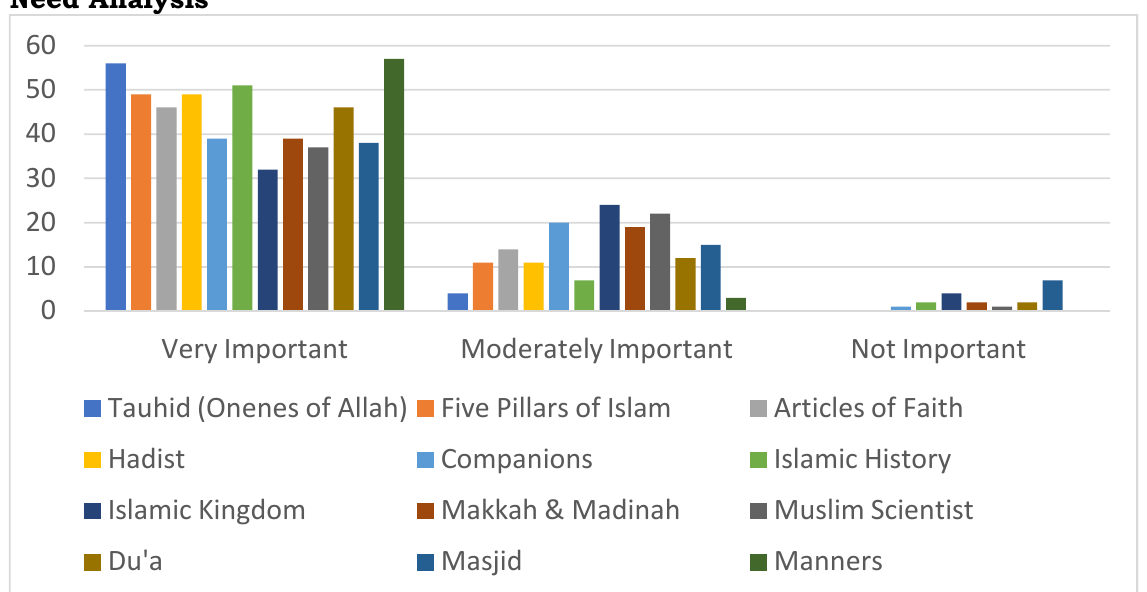
Figure 2. Results of need analysis highlighting on 12 topics of Islamic studies